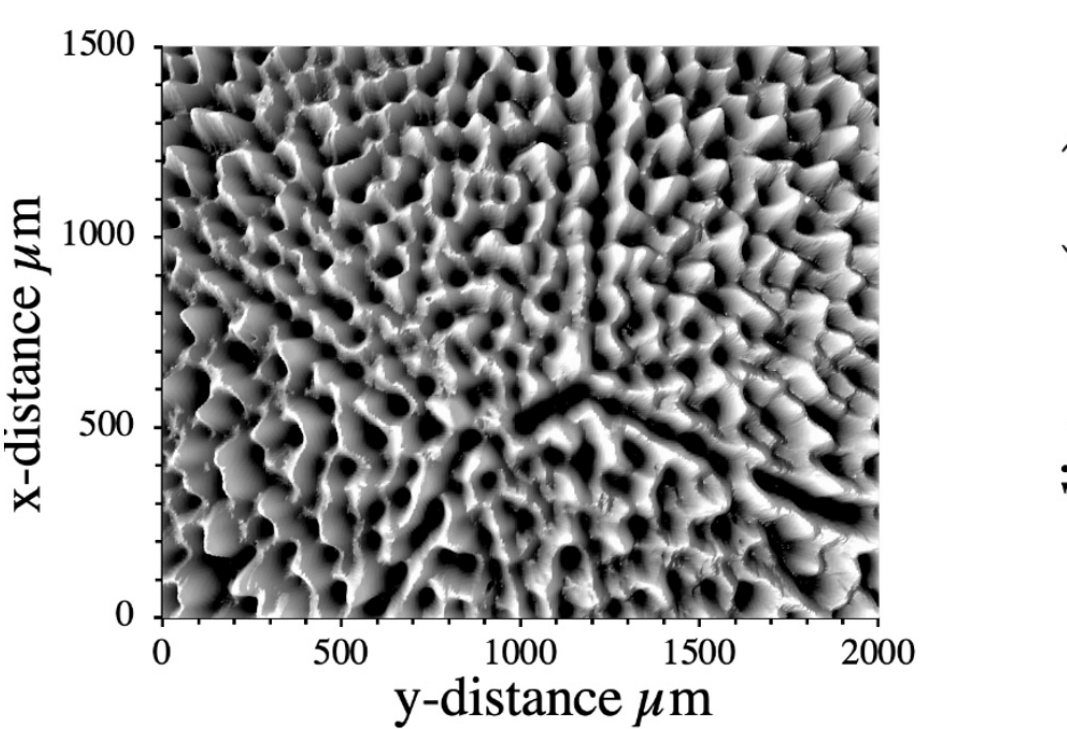
Figure 2. Optical micrograph showing surface morphology at the spinning center of PMMA film produced from 8.0 g/dL and 1000 RPM.